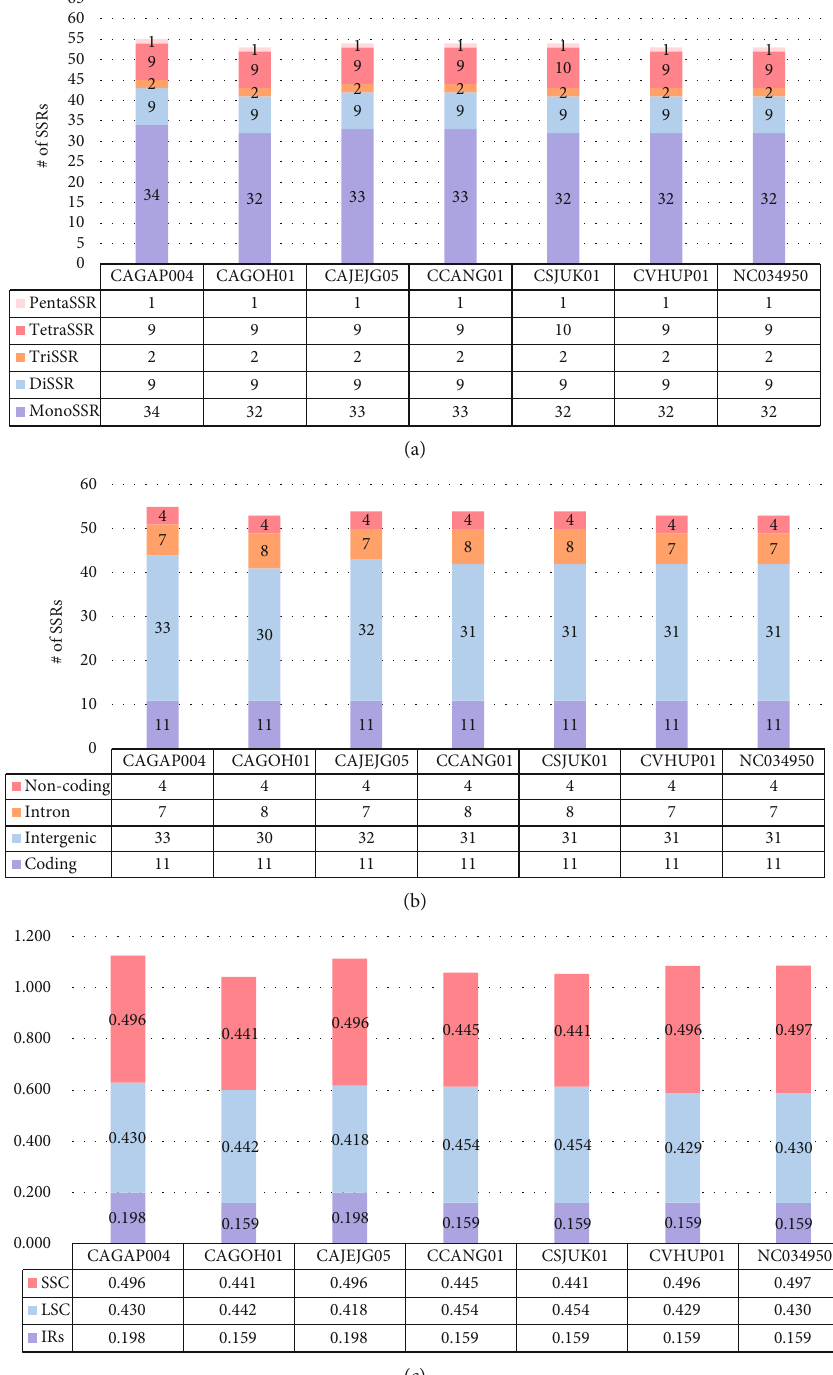
Figure 4: Number of normal SSRs identi fi ed on the seven Chenopodium album chloroplast genomes. (a) Displays the number of SSR types in each seven C. album chloroplast genome. The X -axis means the seven C. album samples, and the Y -axis indicates the number of normal SSRs. Five di ff erent colors indicate the fi ve types of SSRs, monoSSRs, diSSRs, triSSRs, tetraSSRs, and pentaSSRs. The table below the X -axis presents numbers of SSRs along with samples and the fi ve SSR types. (b) Shows the distribution of SSRs in noncoding, intron, intergenic, and coding regions along with the samples. The X -axis means the seven C. album samples, and the Y -axis indicates the number of normal SSRs. Four di ff erent colors correspond to the four di ff erent regions. The table below the X -axis shows the number of SSRs along with samples and regions. (c) Shows SSR density (# of SSRs/kb) of the LSC, SSC, and IR regions along with the samples. The X -axis means the seven C. album samples, and the Y -axis indicates the number of normal SSRs along with samples and the three regions. Three di ff erent colors in the bar graphs mean the three regions. The table below the X -axis shows SSR density along with samples and the three